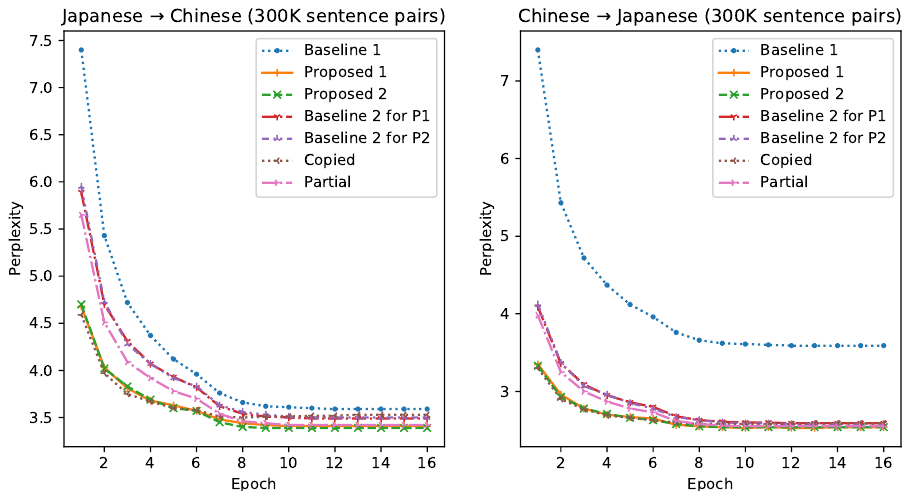
Figure 7. Validation perplexity values on the development data of 300k sentences. “P1” denotes the Proposed 1 method, “P2” denotes the Proposed 2